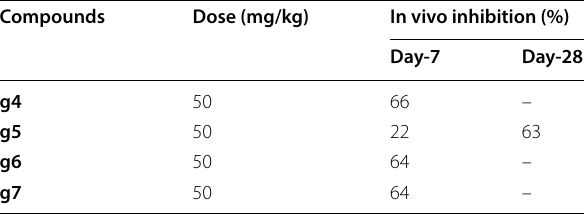
Table 49 Antileishmanial activity